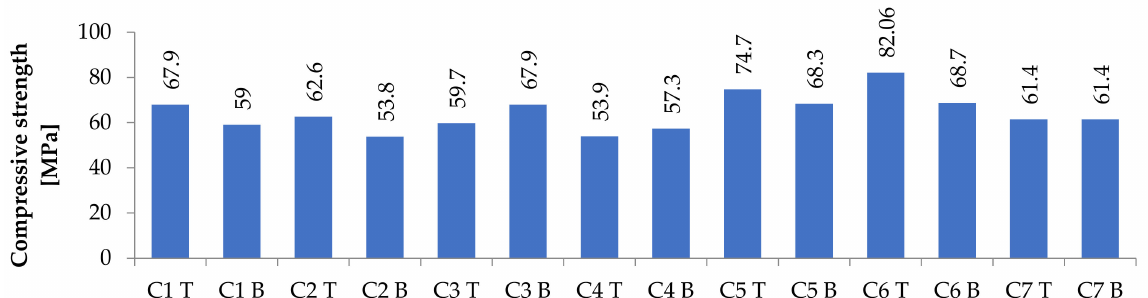
Figure 4. Compressive strength results at the top (T) and bottom (B) parts of columns for individual concrete